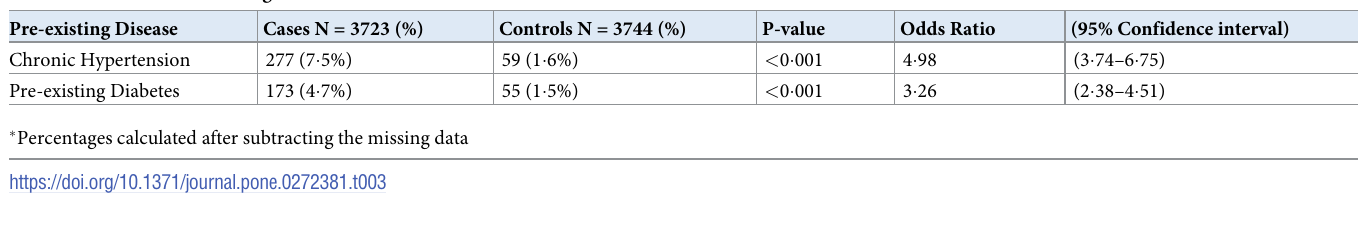
Table 3. Co-morbidities among cases and